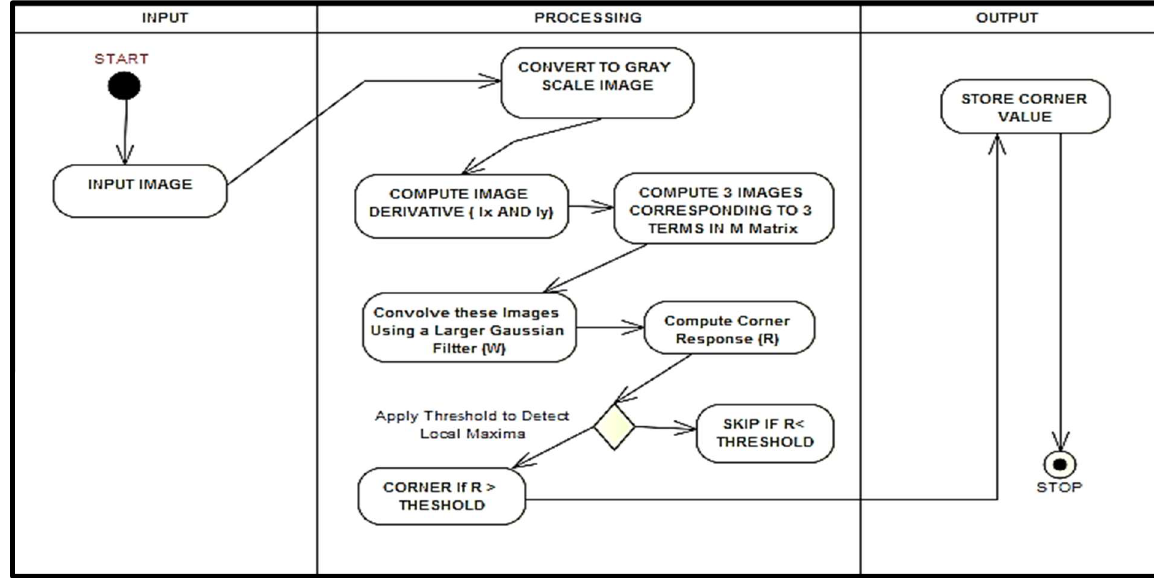
Figure 1: Activity diagram of Harris corner detection algorithm